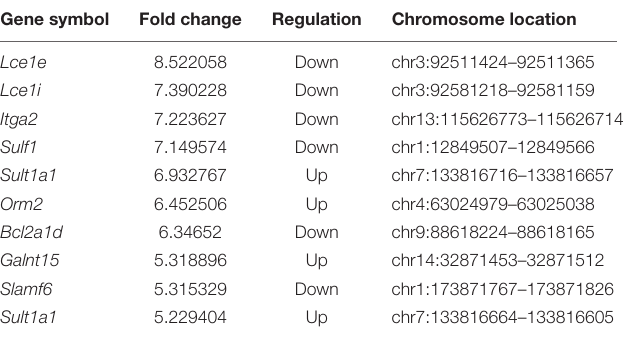
TABLE 2 | The top 10 differentially expressed mRNAs.